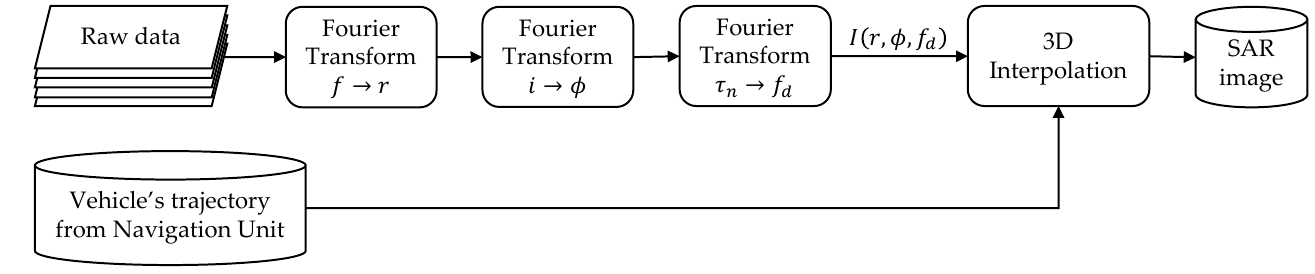
Figure 8. Block diagram of the Quick&Dirty (Q&D)